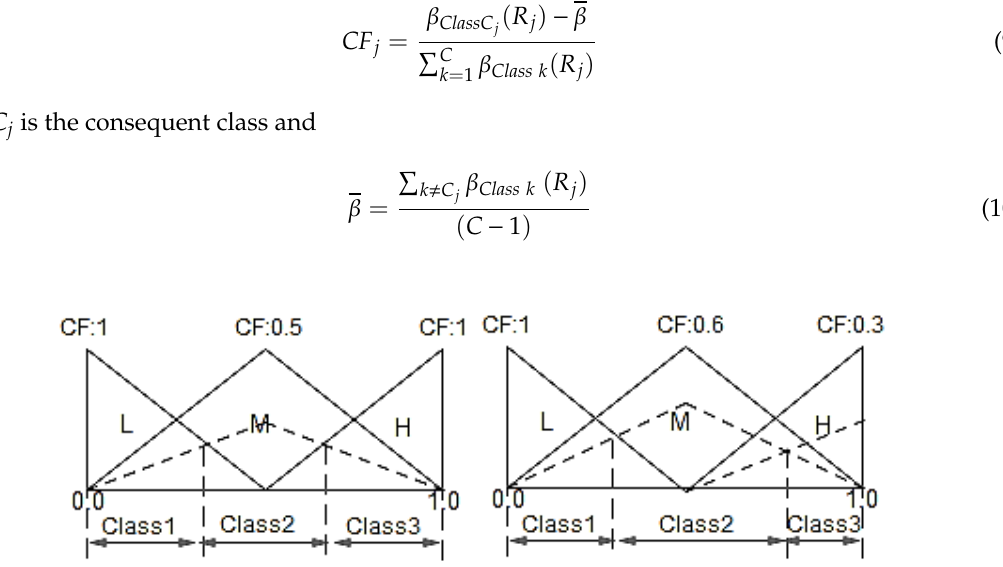
Figure 10. Membership linguistic variables boundaries with different CF. Figure 9. Membership linguistic variables boundaries without CF.